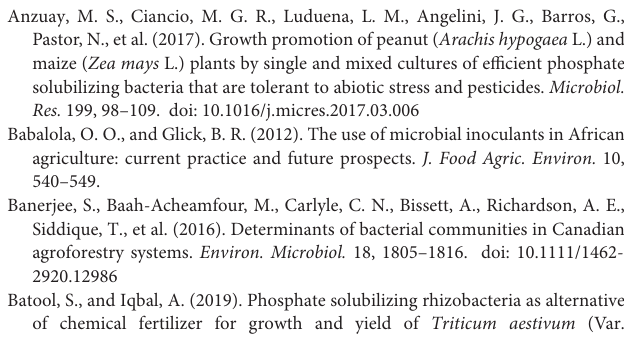
Supplementary Table 1 | PCR primers for 16S rRNA and ITS in this work. Supplementary Table 2 | PCR amplification process of 16S rRNA gene and ITS gene. Supplementary Table 3 | Correlation coefficient between environmental factors and microbial structure. Supplementary Table 4 | Bacterial network structure properties. Supplementary Table 5 | Fungal network structure